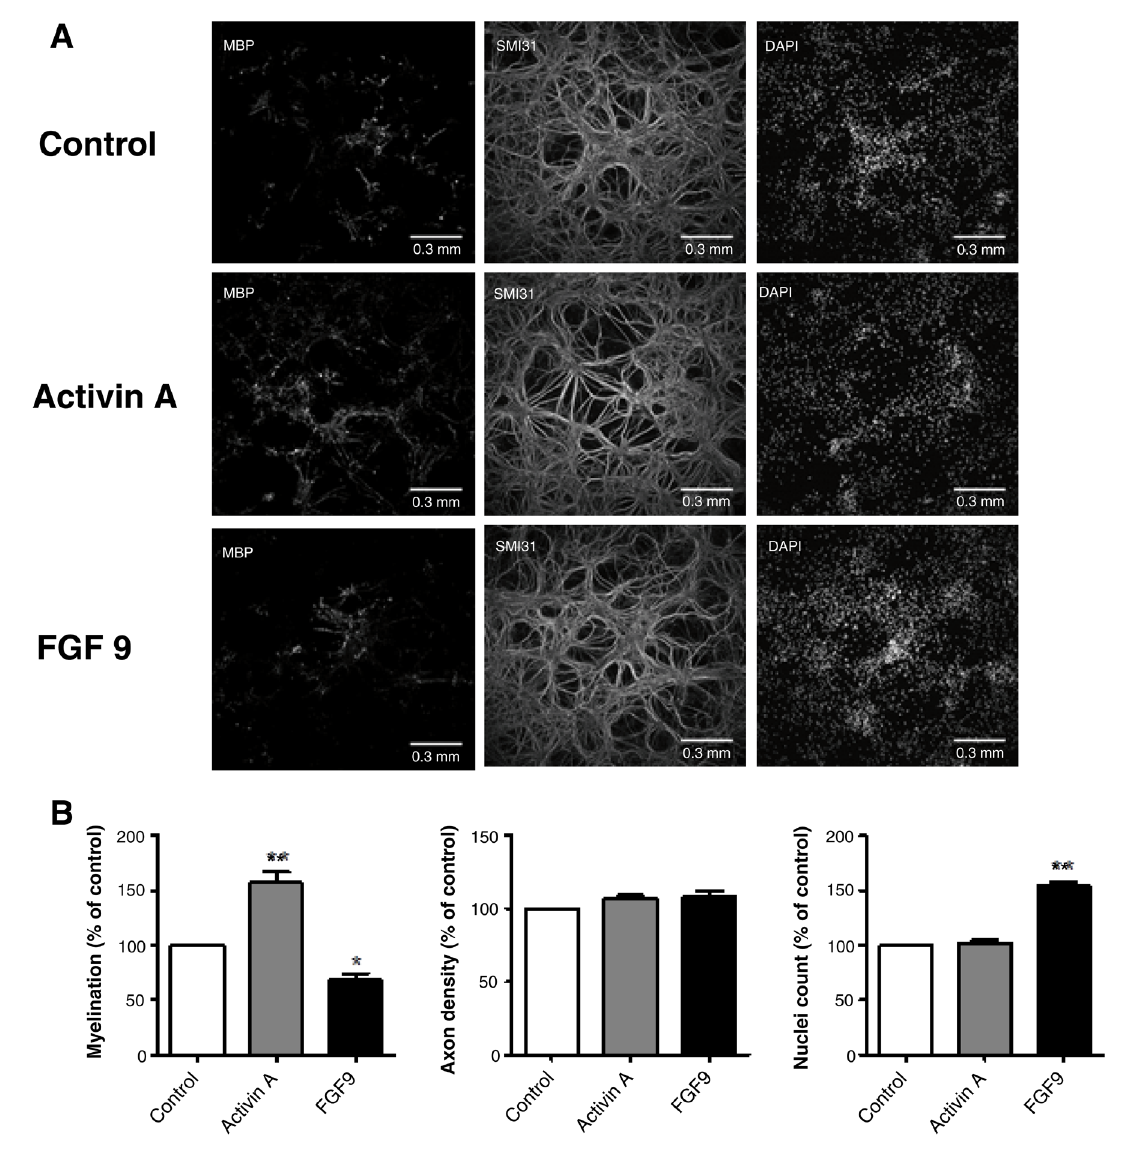
Figure 6. Spinal cord cultures grown in 96-well microplates are amenable to modulators of myelination. A . Representative immunofluorescence images of 96-well microplate myelinating cultures (28 DIV) stained for MBP, phosphorylated neurofilament (SMI31) and nuclei (DAPI). Cells were untreated or treated with Activin-A or FGF9 as described. B . Percentage change in myelination, axon density and nuclei count after treatment with Activin-A or FGF9. Bars represent average values from 5 independent cultures, each with 5 wells of technical replicates (wells), +/- s.e.m.. Raw data attached. Cells were allocated to different treatments as described in Materials and Methods. * p < 0.05, **p <